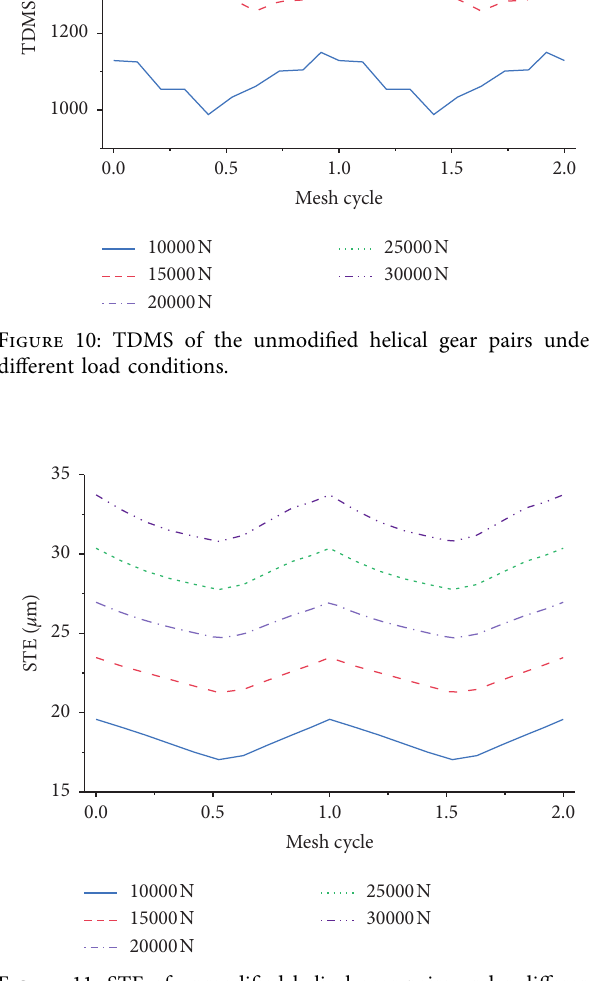
Figure 13: STE of unmodified helical gear pairs under different mesh misalignment